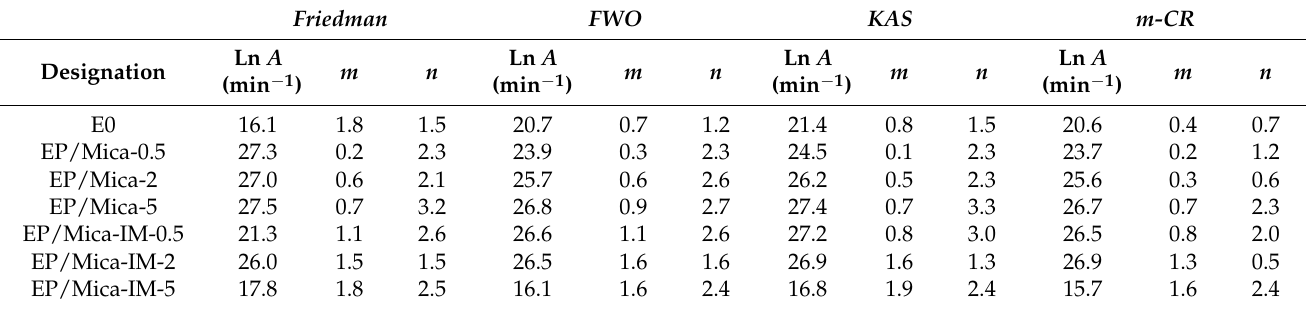
Table 6. Parameters of degradation kinetics obtained for the studied